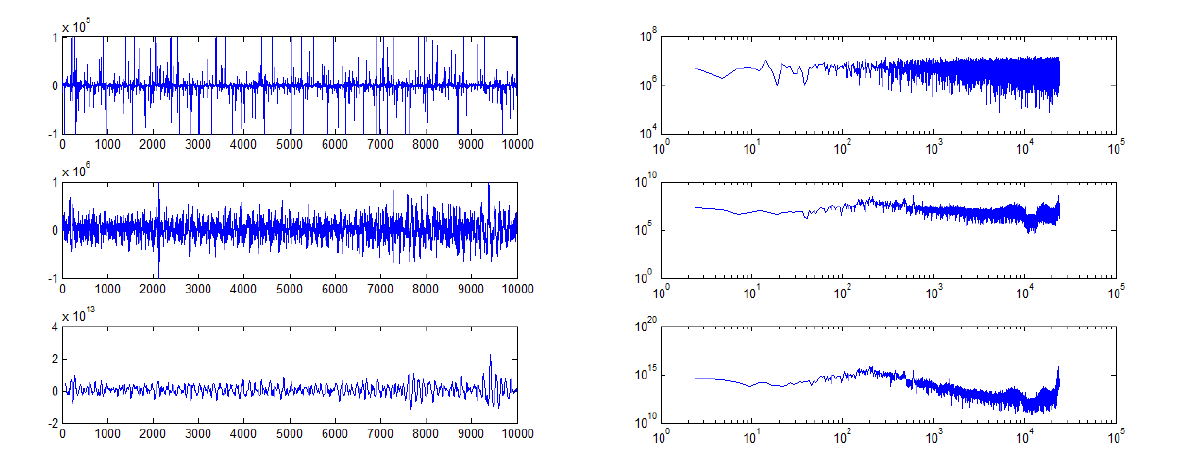
Figure 4 the adaptive filtering